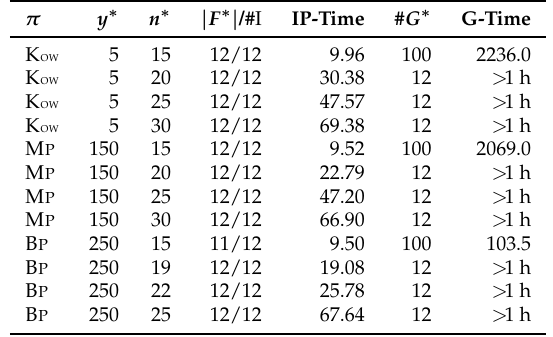
Table 3. Results of Steps 4 and 5 with d max = 3 and θ = − 2.